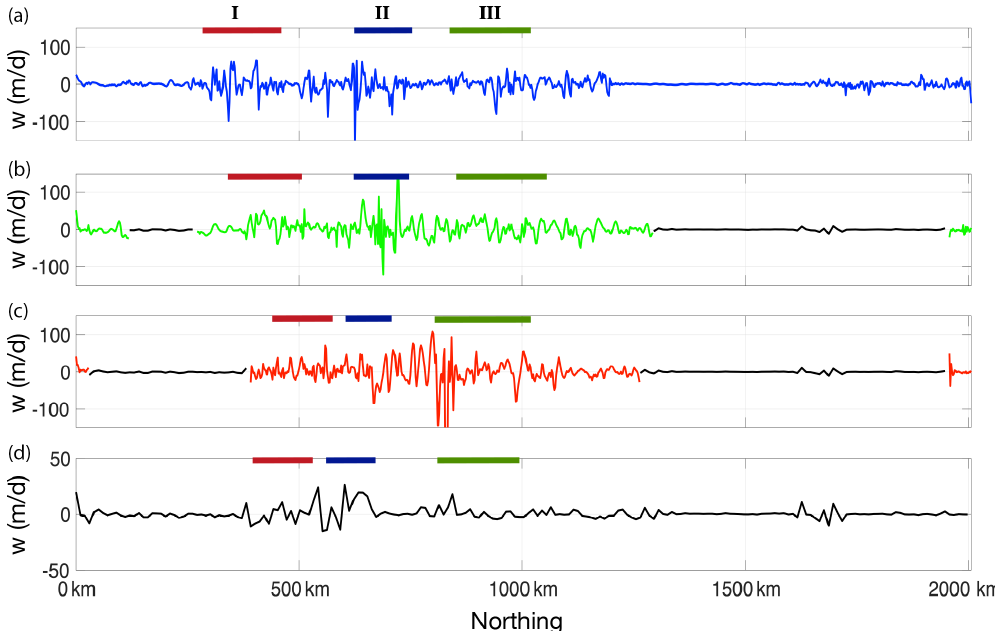
Figure 15. Vertical speed ( w , md − 1 ) at 50m depth ( k = 7) on the meridional–vertical transects in Fig. 14. Panel layout, as well as the three features, is the same as in Fig. 14. In (b) – (d) , the region with 0.1 ◦ (0.02 ◦ ) resolution is marked by black lines (colored lines). Note that the range is different in (d) due to the overall smaller vertical speed in the full-field 0.1 ◦ experiment (i.e.,